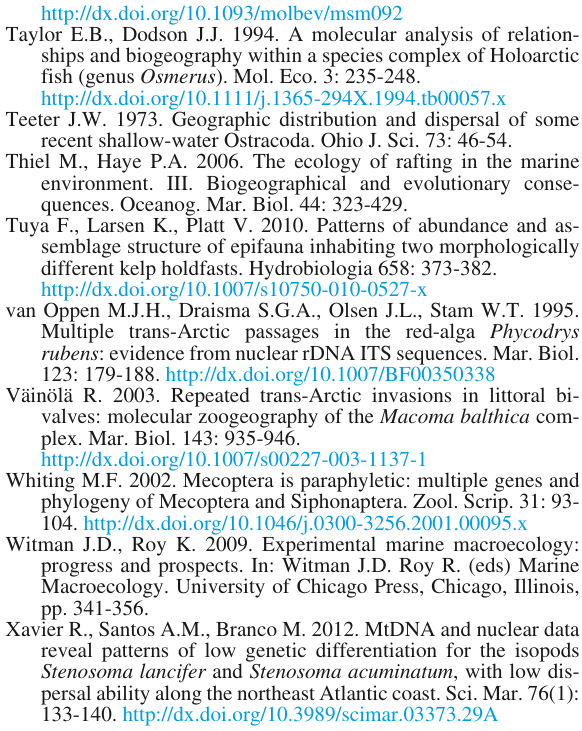
Fig. S1. – Maximum likelihood (ML) tree for the H3, inferred using the HKY+G model of sequence evolution showing relation- ships of Zeuxo sp. from different locations. The tree is rooted using Tanais dulongii and Paratanais sp. Bootstrap values above 60% are shown below nodes, and posterior probability values for the Bayesian analysis are above nodes. Fig. S2. – Maximum likelihood (ML) tree for the COI, inferred us- ing the HKY+G model of sequence evolution showing relation- ships of Zeuxo sp. from different locations. The tree is rooted using Tanais dulongii and Paratanais sp. Bootstrap values above 60% are shown below nodes, and posterior probability values for the Bayesian analysis are above